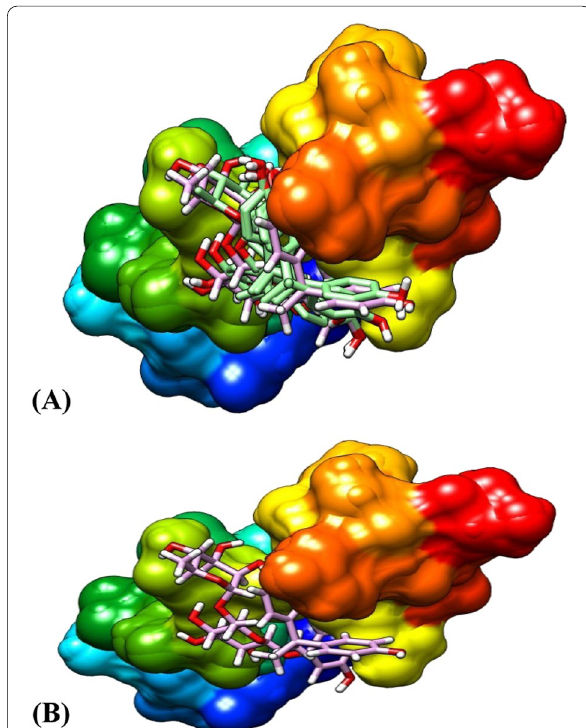
Fig. 4 The binding pose of the ligands at the same binding site of FGF-21. (A) . The best model of hesperidin in complex with 8 models of bisphenol A. (B) The binding pose of the best conformation of the Ligands and the